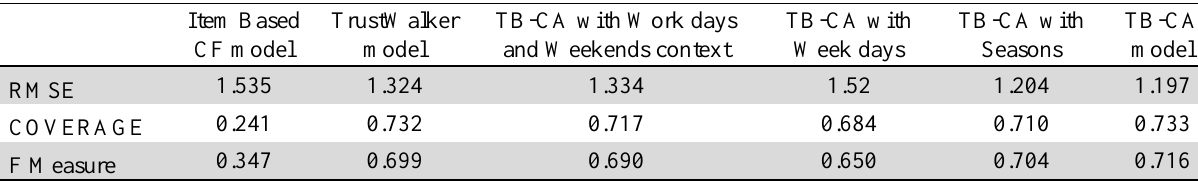
Results for cold start